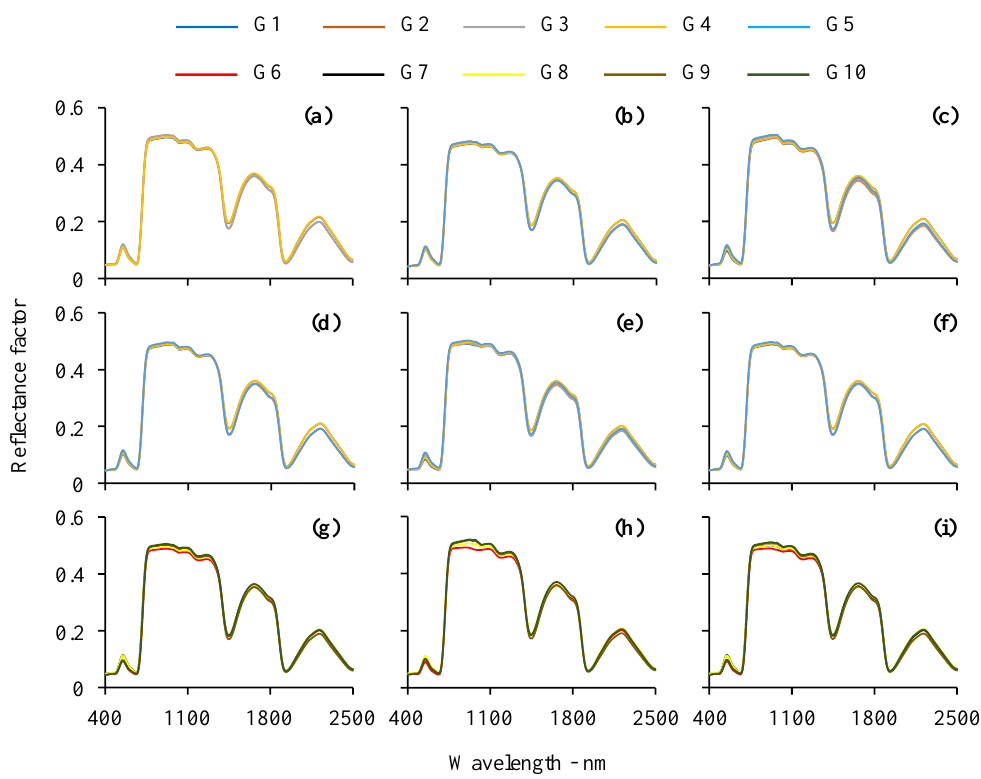
Figure 6. Average reflectance spectra of soybean genotypes 1, 2, 3, 4, 5, 6, 7, 8, 9, and 10 in Embrapa 2016/2017 ( a ), Embrapa 2017/2018 ( b ), Embrapa 2018/2019 [I] ( c ), Embrapa 2016 – 2019 ( d ), Unoeste 2018/2019 [I] ( e ), Embrapa 2016 – 2019 + Unoeste